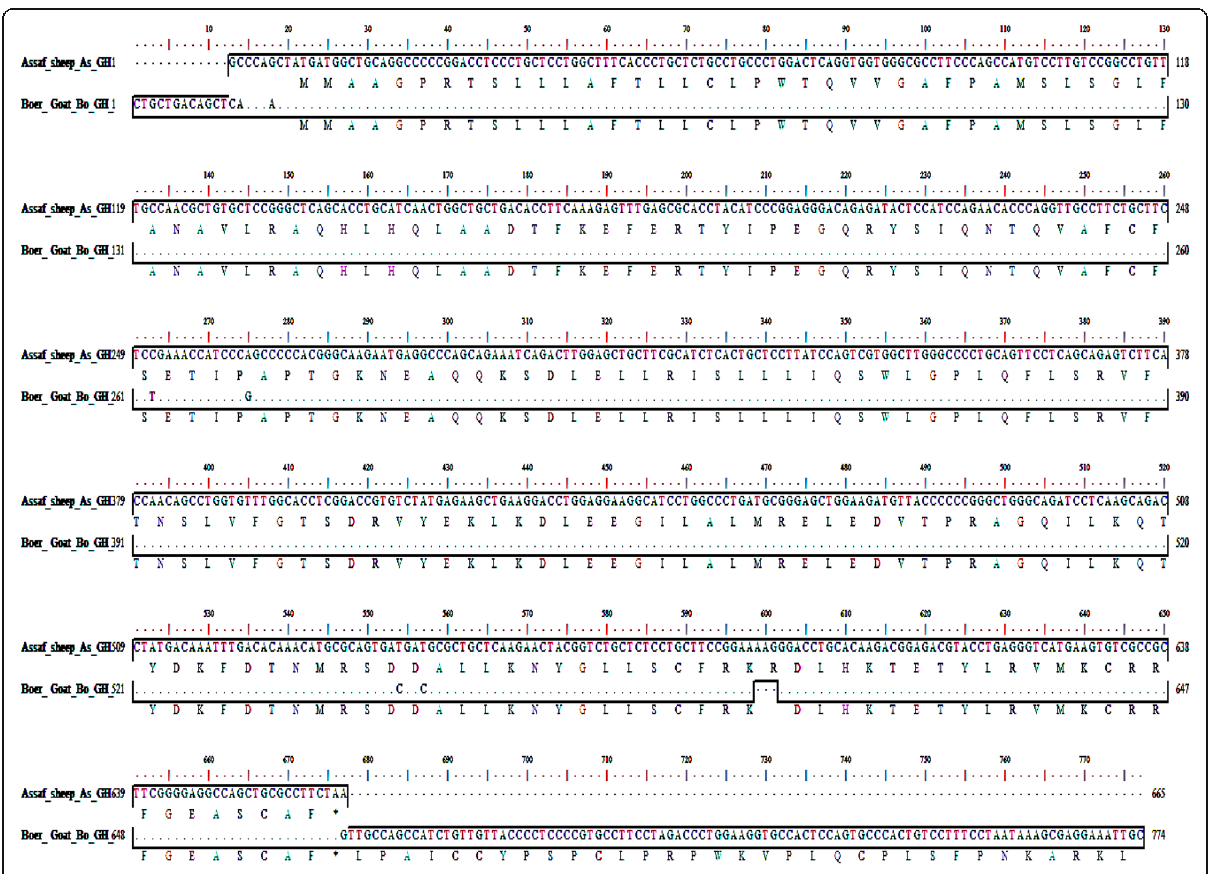
Fig. 5 Pairwise alignment of Assaf_GH and Boer_GH cDNA sequences with their predicted protein